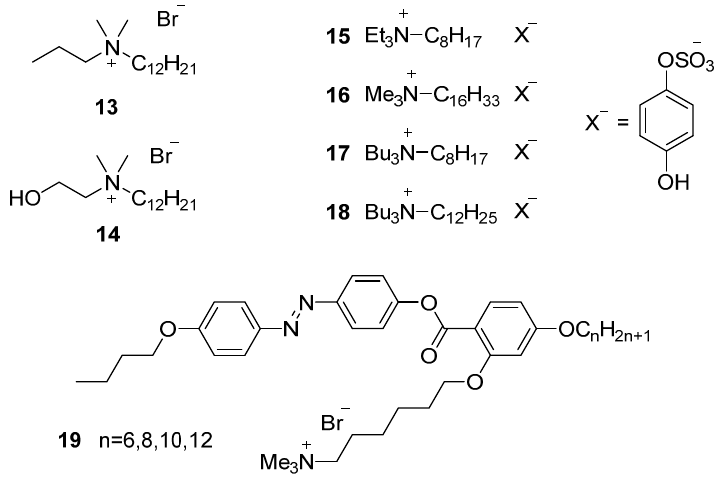
Figure 4. Ammonium-based ILCs with a single long aliphatic tail.